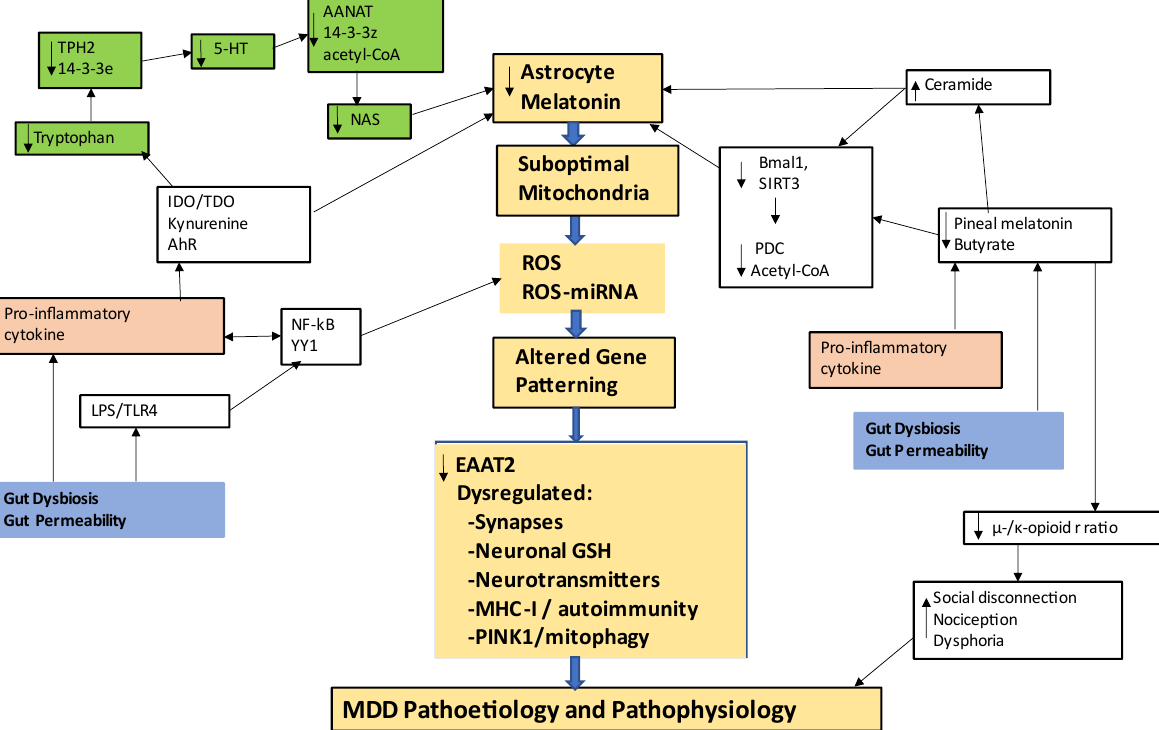
Figure 1. Shows how an array of different processes can impact mitochondrial function, highlighting factors regulating the astrocyte mitochondrial melatonergic pathway and its consequences for MDD pathophysiology (gold shade). The tryptophan-melatonin pathway is shaded in green. Tryptophan is taken up into cells where it is converted to serotonin by tryptophan hydroxylase (TPH2). In astrocytes, TPH2 requires 14-3-3 ε for stabilization. Serotonin (5-HT) is converted to N-acetylserotonin (NAS) by AANAT, which requires 14-3- 3ζ for stabilization, as well as acetyl -CoA. Factors suppressing the availability of these 14-3-3 isoforms will limit melatonergic pathway induction. The AhR and ceramide can suppress 14-3-3, thereby suppressing the melatonergic pathway. The AhR, purinergic P2Y1 and metabotropic glutamate receptor (mGluR)5 can ‘backward’ convert melatonin to NAS via O-demethylation (P2Y1 and mGluR5 not shown for clarity). Gut dysbiosis and gut per- meability (blue shade) increase LPS and suppress butyrate, in conjunction with increased pro-in- flammatory cytokines. Pro-inflammatory cytokines and stress/cortisol increase IDO and TDO, de- pleting tryptophan by converting it to kynurenine, which activates the AhR as well as leading to neuroregulatory kynurenine pathway products. Pro-inflammatory cytokines and LPS also suppress pineal melatonin, contributing to the loss of the circadian ‘resetting’ of mitochondria via pineal mel- atonin induction of Bmal1 and, like butyrate, sirtuin-3. Bmal1 and sirtuin-3 disinhibit PDC increas- ing pyruvate conversion to acetyl-CoA, which is necessary to induce the melatonergic pathway. The decrease in butyrate attenuates its induction of the μ -opioid receptor, thereby impacting on immune regulation, social processes and nociception. LPS and pro-inflammatory cytokines increase inflam- matory factors via the transcription factors, NF-kB and YY1, which are normally dampened by their sequential induction of melatonin via melatonin’s intracrine, autocrine and paracrine effects. The impact of the gut and circadian dysregulation thereby has consequences for mitochondrial metabo- lism and increased ROS, leading to alterations in patterned miRNAs and consequently in patterned gene expression. Such alterations in astrocytes change neuronal regulation and transmitter release, with differential effects in distinct brain regions genetically and epigenetically primed by develop- mental processes. Abbreviations: AANAT: aralkylamine N-acetyltransferase; AhR: aryl hydrocar- bon receptor; ASMT: N-acetylserotonin O-methyltransferase; CYP: cytochrome P450; IDO: in- doleamine 2,3-dioxygenase; LPS: lipopolysaccharide; MHC-I: major histocompatibility complex- class I; NAS: N-acetylserotonin; NF-kB: nuclear factor kappa-light-chain-enhancer of activated B cells; PDC: pyruvate dehydrogenase complex; PINK1: PTEN-induced kinase 1; ROS: reactive oxy- gen species; TDO: tryptophan 2,3-dioxygenase; TLR: Toll-like receptor; YYI: yin yang 1. The butyrate optimization of mitochondrial function requires the melatonergic path- way [115], via butyrate/sirtuin-3/PDC providing the acetyl-CoA that is a necessary co-